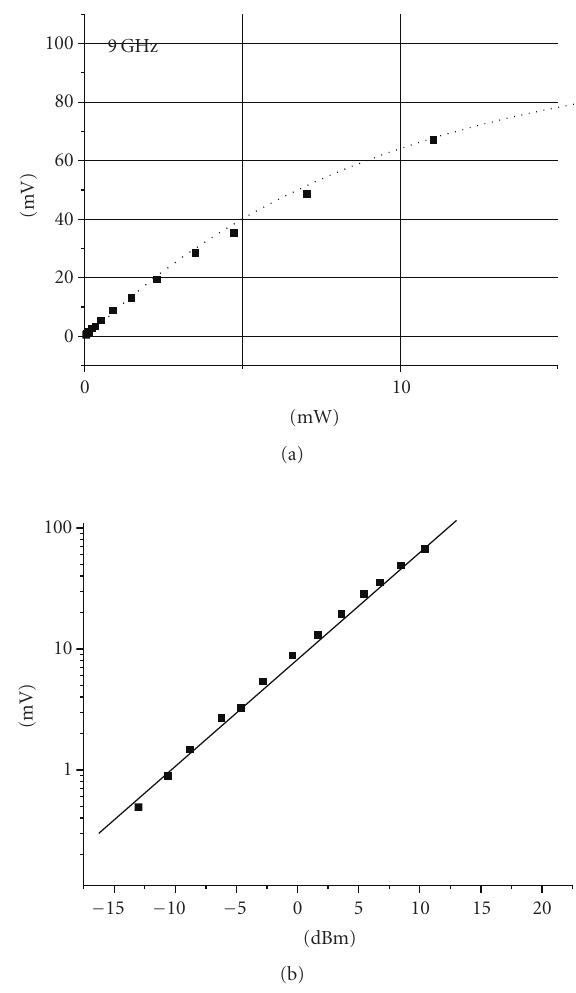
Figure 4: (a) The detector output voltage in the function of the power feed in the calibrated antenna. The doted line is the exponential fit. (b) The same curve plotted in log-log